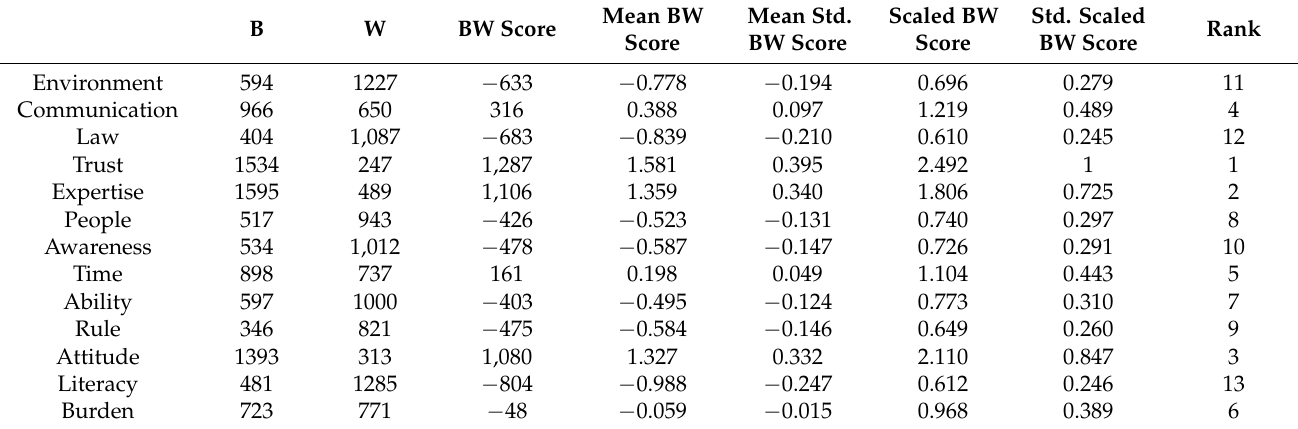
Table 4. The results of the best-worst scaling survey.